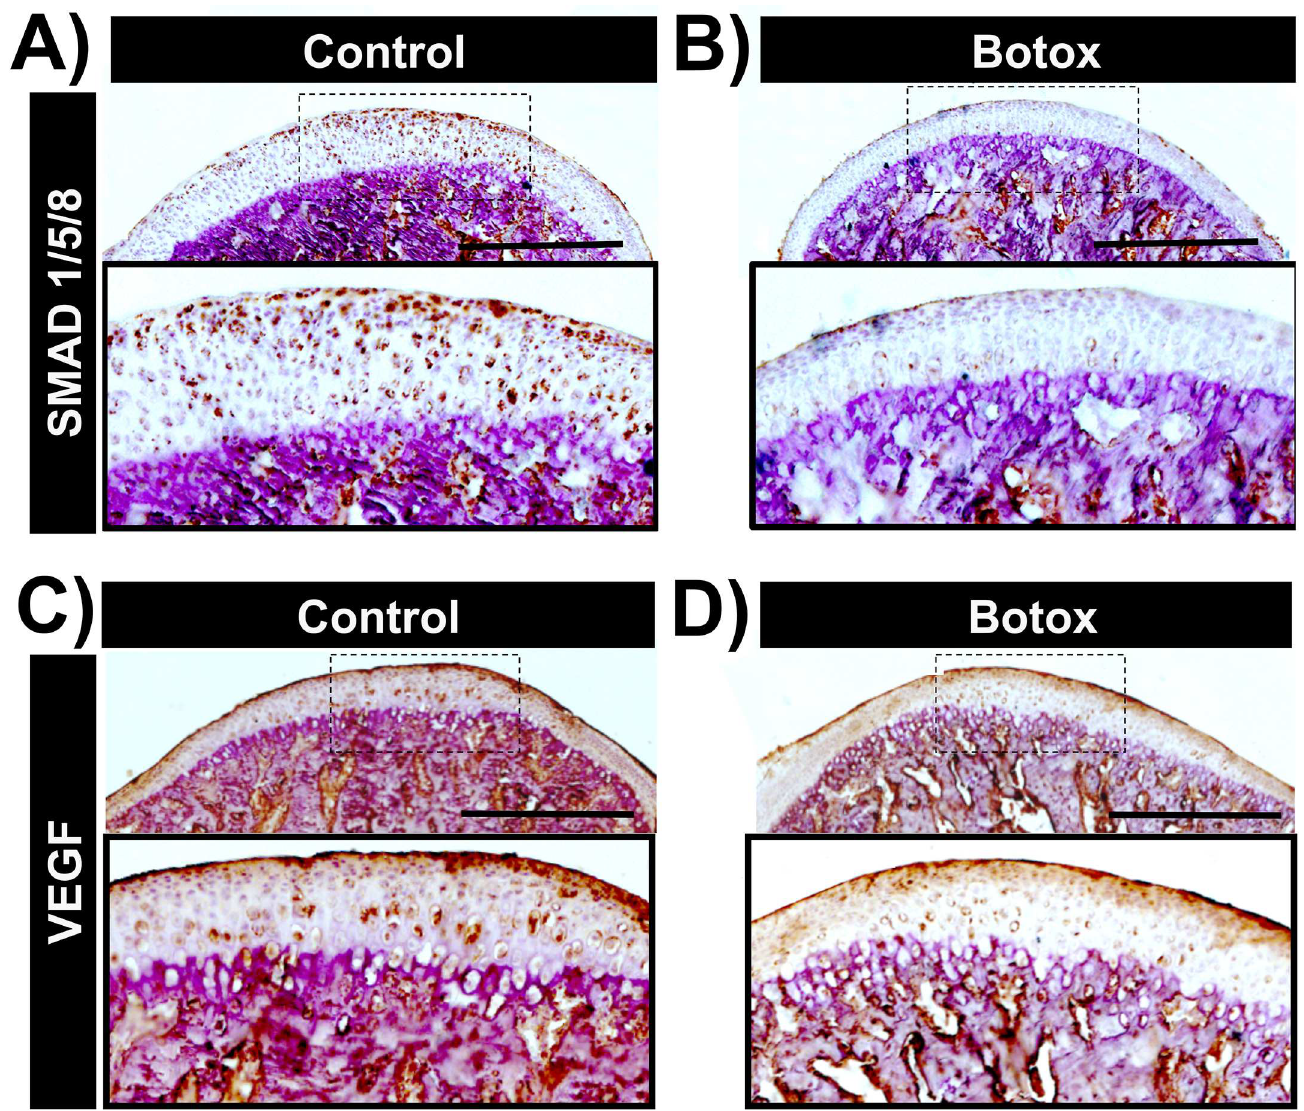
Fig 5. Decreased expression of SMAD1/5/8 and VEFG in the Botox injected side MCC and subchondral bone. Immunohistochemistry for SMAD1/5/8 in sagittal sections of control (A) and Botox (B) injected side condyles. VEGF Immunohistochemistry in sections of control (C) and Botox (D) injected side condyles. Scale bar = 500 μ